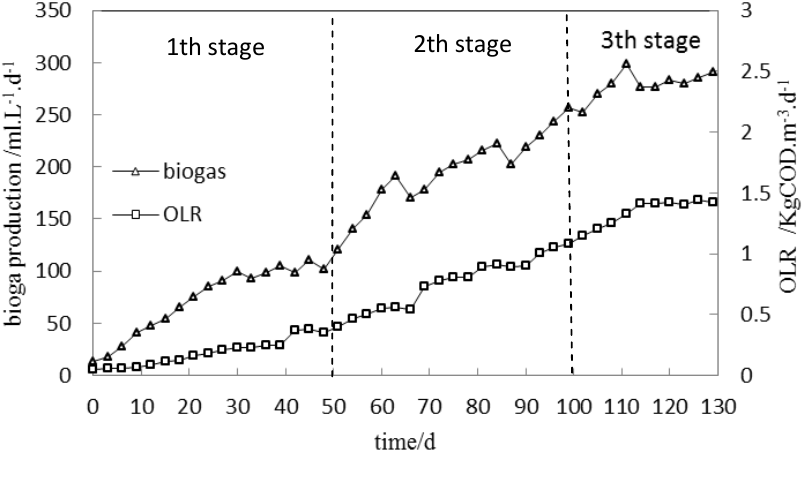
Figure 3. Impact of the organic loading rate (OLR) on biogas